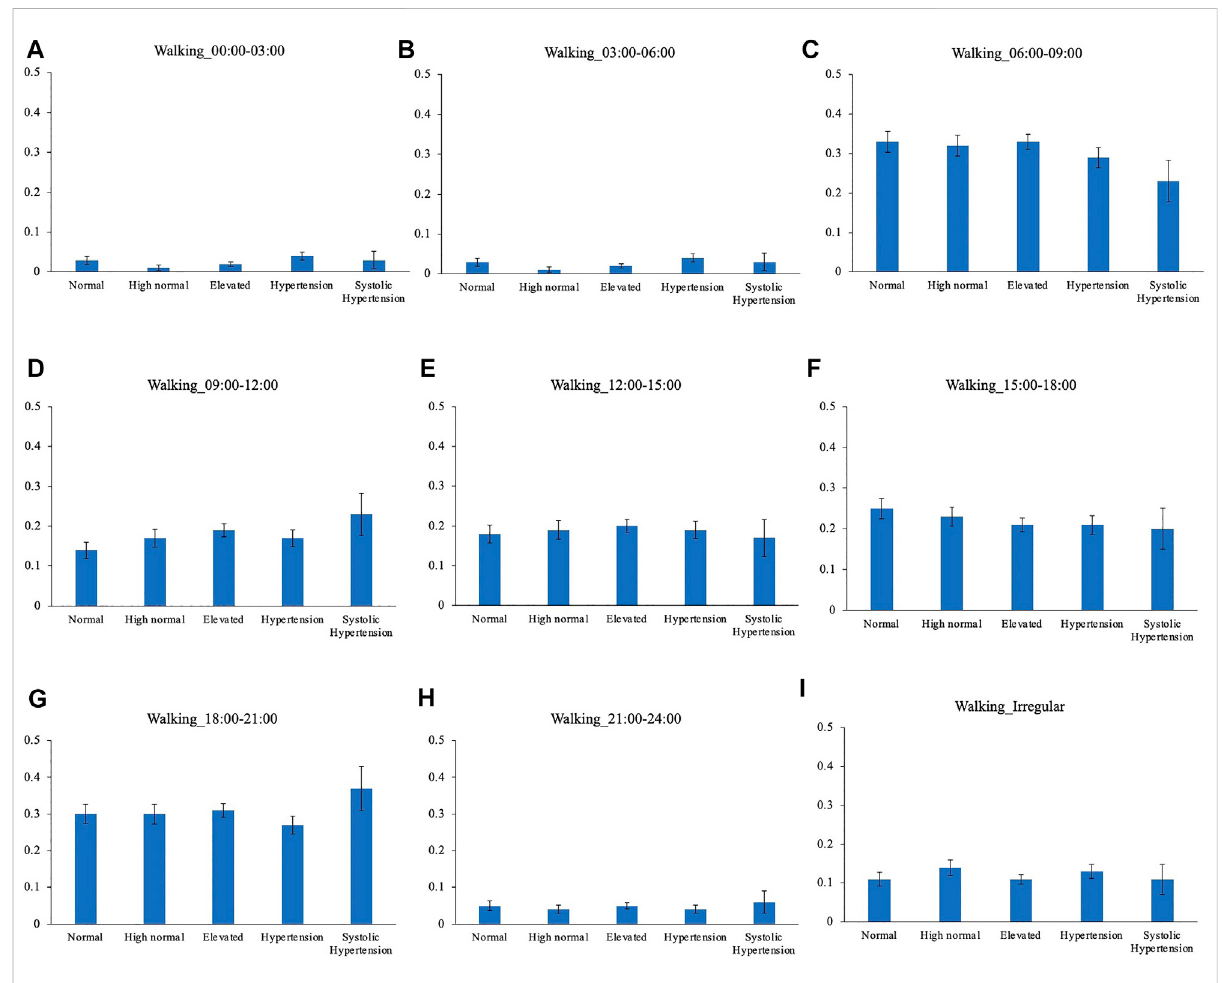
FIGURE 8 BPcategoriesandwalkingfrequencyforeachtimeperiod. (A) 00:00 – 03:00 (B) 03:00 – 06:00 (C) 06:00 – 09:00 (D) 09:00 – 12:00 (E) 12:00 – 15: 00 (F) 15:00 – 18:00 (G) 18:00 – 21:00 (H) 21:00 – 24:00 (I) Irregular